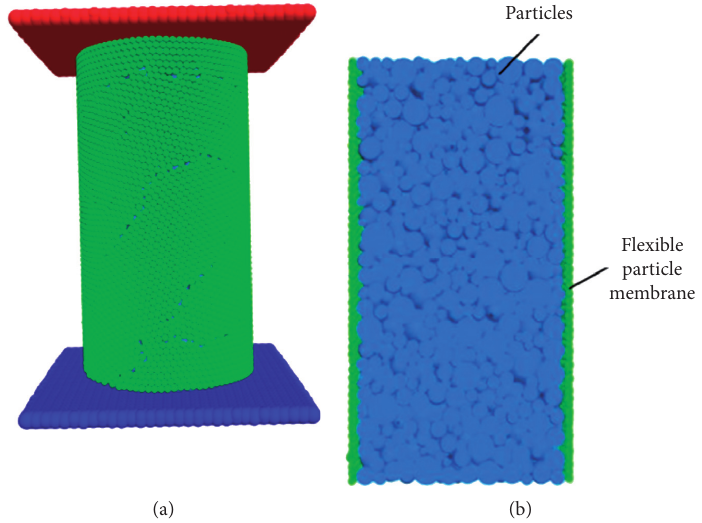
Figure 2: Schematic diagram of lateral wall and loading plates. (a) 3D view. (b) Flexible particle Table 2: Weighted average radius of soil particles.